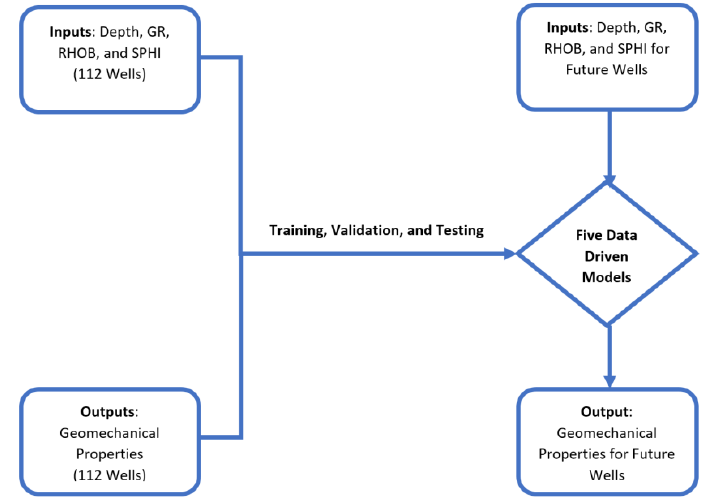
Figure 11. Flowchart process to obtain models to predict geomechanical properties for future